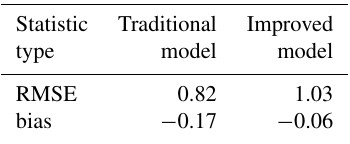
Table 6. Statistics of two models’ tomography accuracy with re- spect to radiosonde data for the experimental period (unit: gm − 3 ).